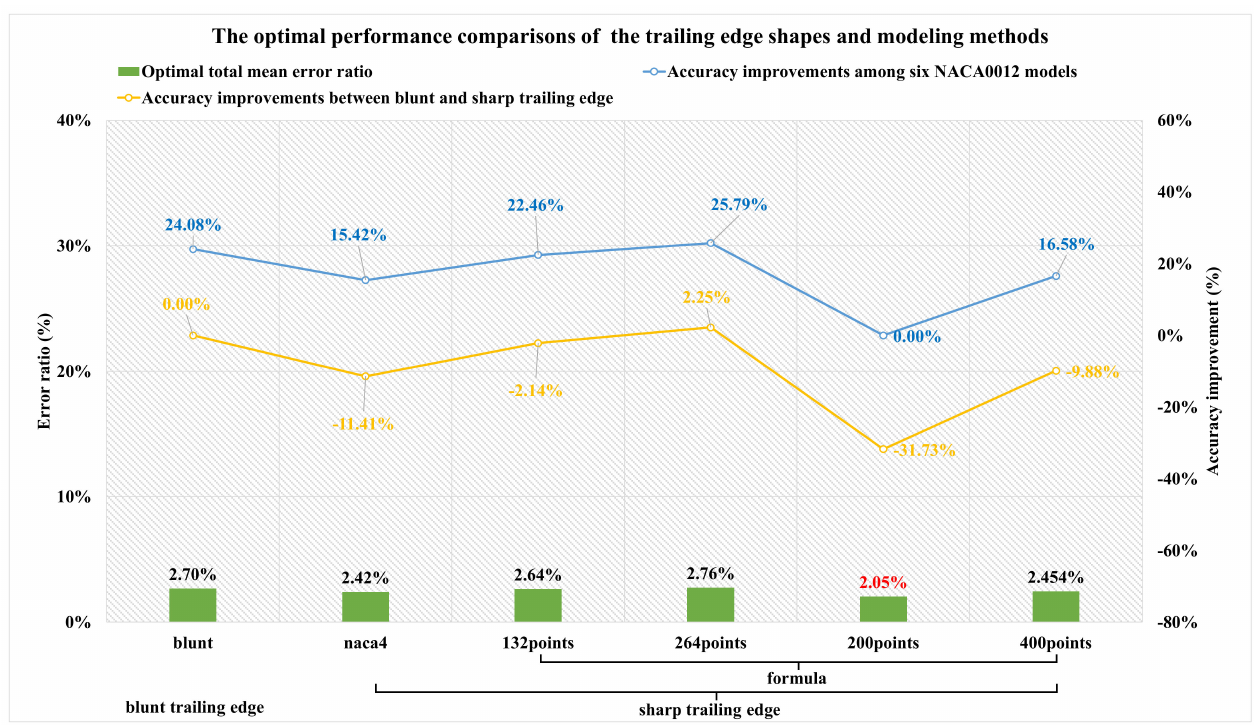
Figure 37. The optimal performance comparisons of trailing edge shapes and the modeling methods. The optimal total error ratios of far-field distances, turbulence models, flux types,